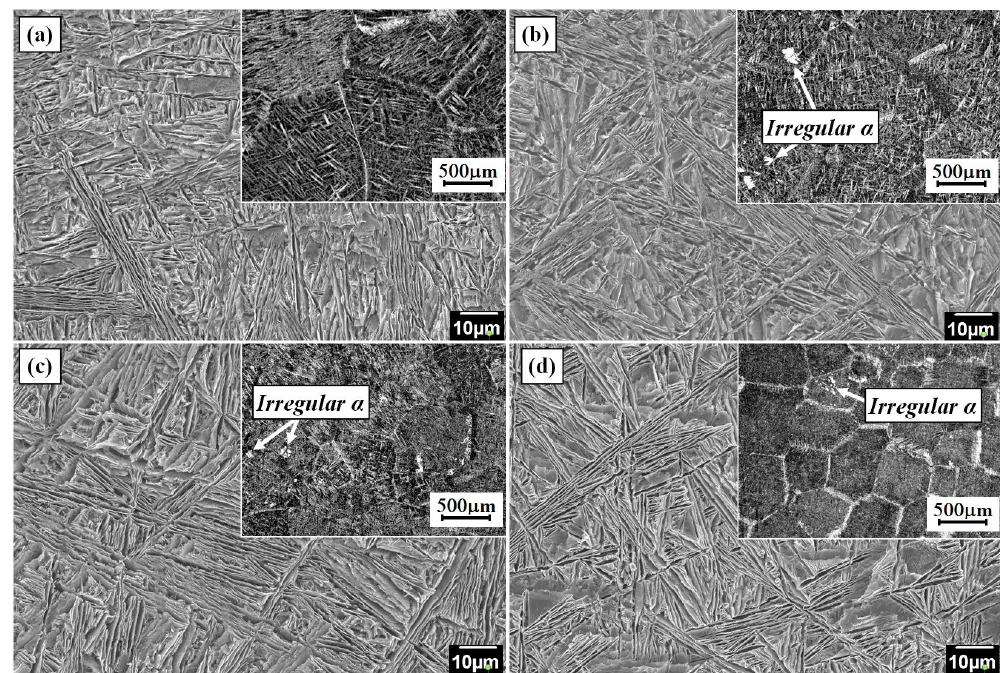
Figure 1. SEM micrographs of furnace-cooled samples: (a) Ti-15Nb, (b) Ti-15Nb-0.15Si, (c) Ti-15Nb-0.35Si, (d) Ti-15Nb-0.55Si. Inserts (a-d) present OM micrographs under lower